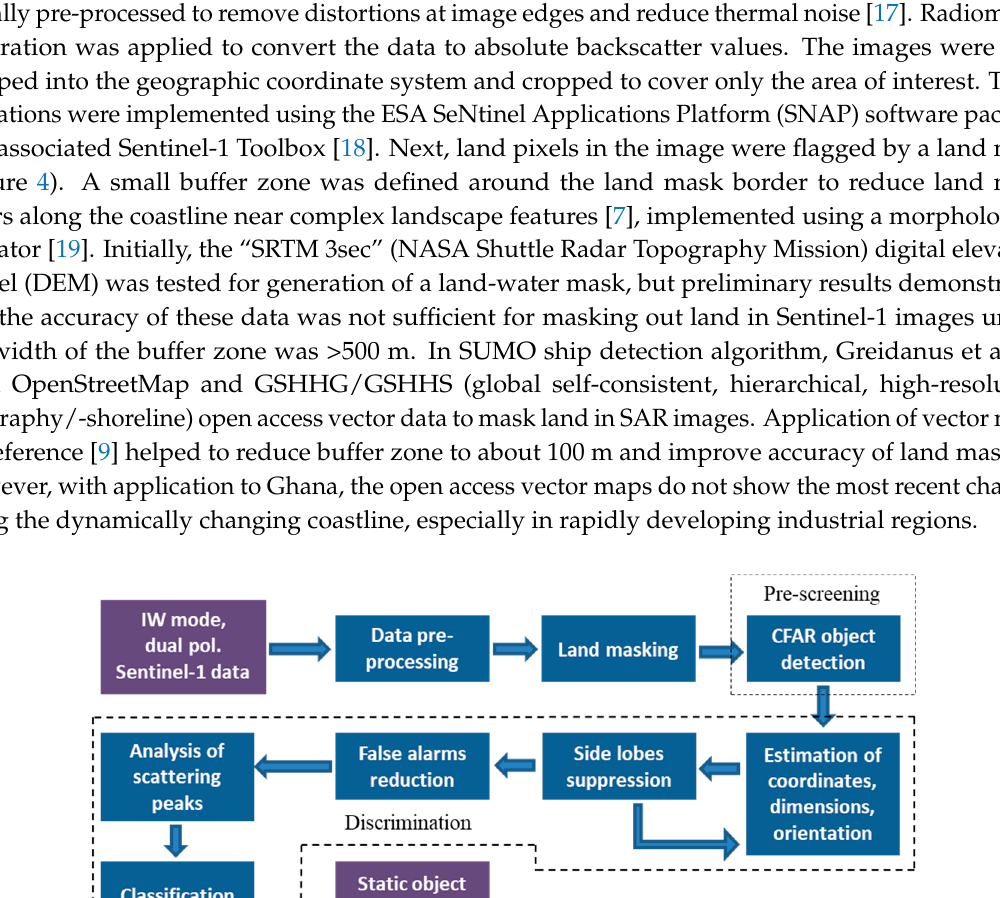
Figure 4. A section of a Ghana land–water mask generated using Sentinel-1 SAR data (from left to right: Songaw Lagoon, River Volta, and Keta Lagoon).